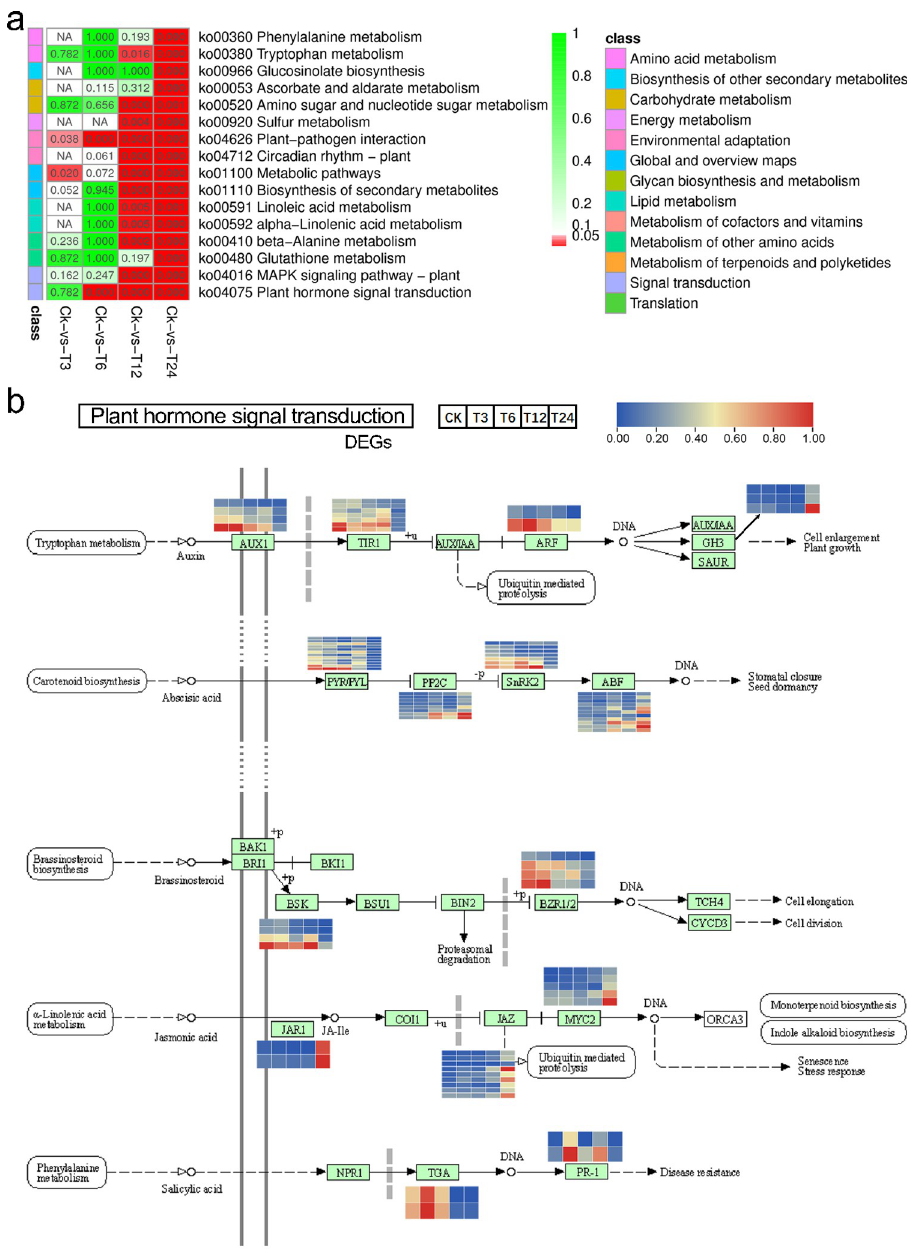
Fig 3. Kyoto Encyclopedia of Genes and Genomes (KEGG) pathway analysis results and expression of key regulators. (a). Heatmap of KEGG pathways in different comparisons. Red cell means p < 0.05, the redder the color, the lower the p -value. green cell means p > 0.05, the greener the color, the higher the p -value. The figures in the cells respects the p -value. (b) shows the expression profiles of DEGs in plant hormone signal transduction pathway. Blue and red cell respect a decrease and an increase of a DEG,